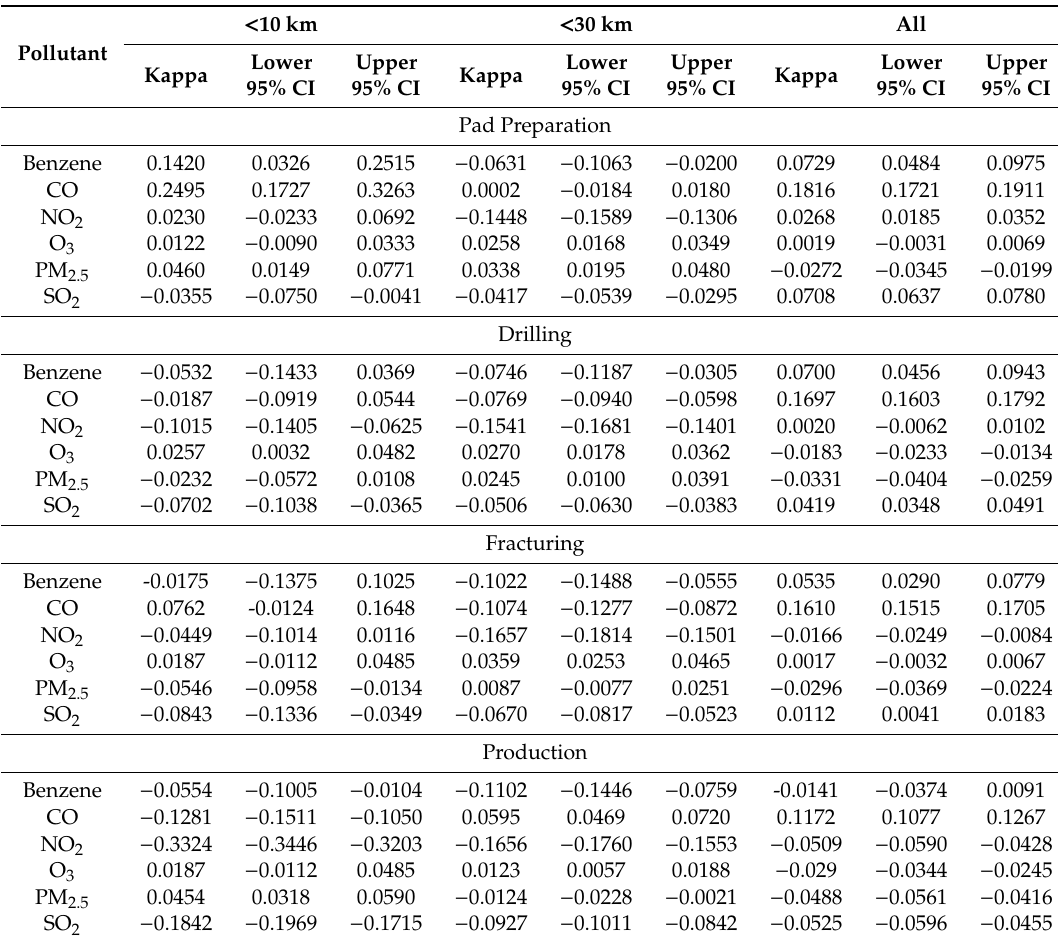
Table 3. Results of sensitivity analysis comparing weighted kappa values for monitors with 10- and 30-km bu ff er zones applied, and results for all monitors regardless of distance to nearest